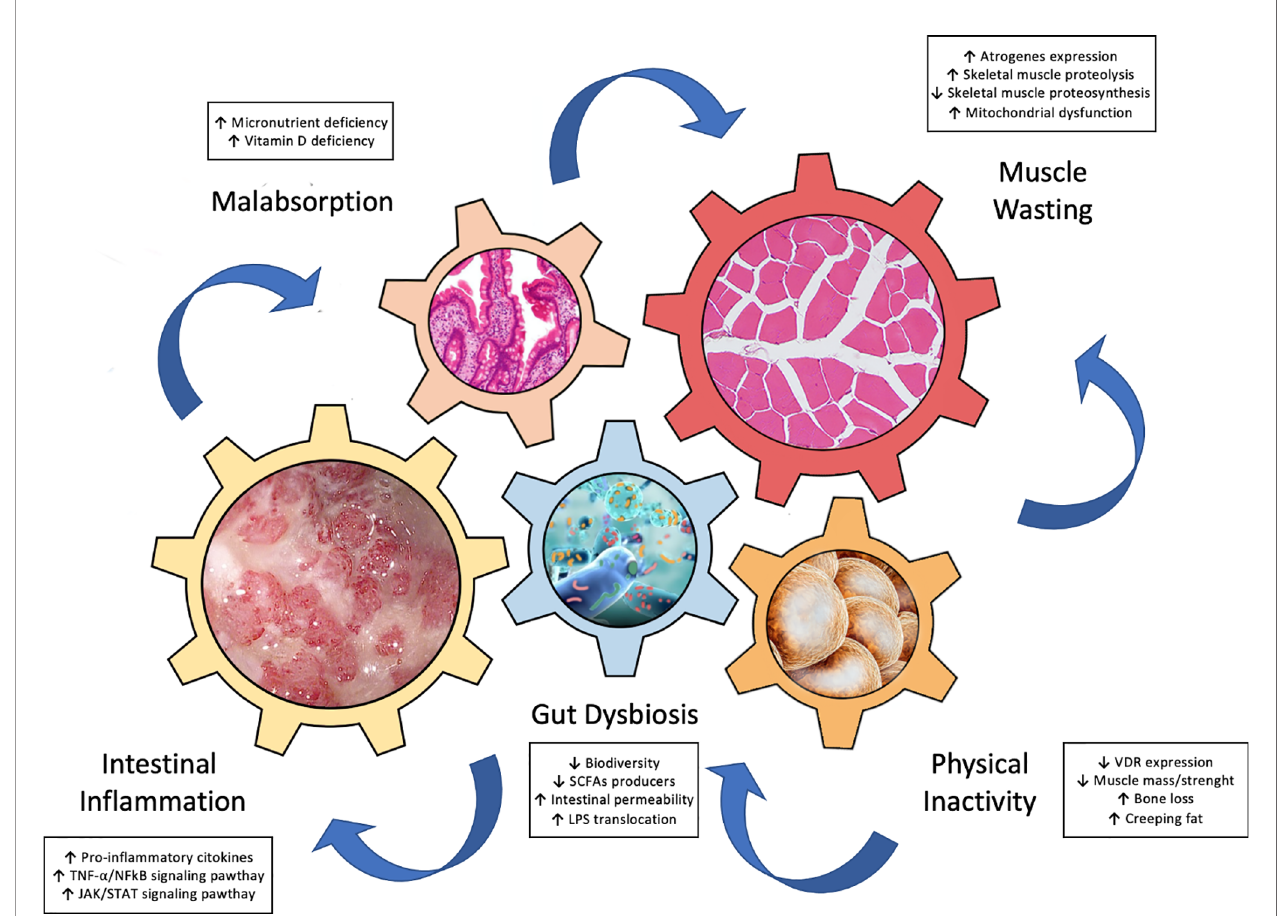
FIGURE 1 | Key drivers involved in the pathogenesis of “ gut-muscle axis ”